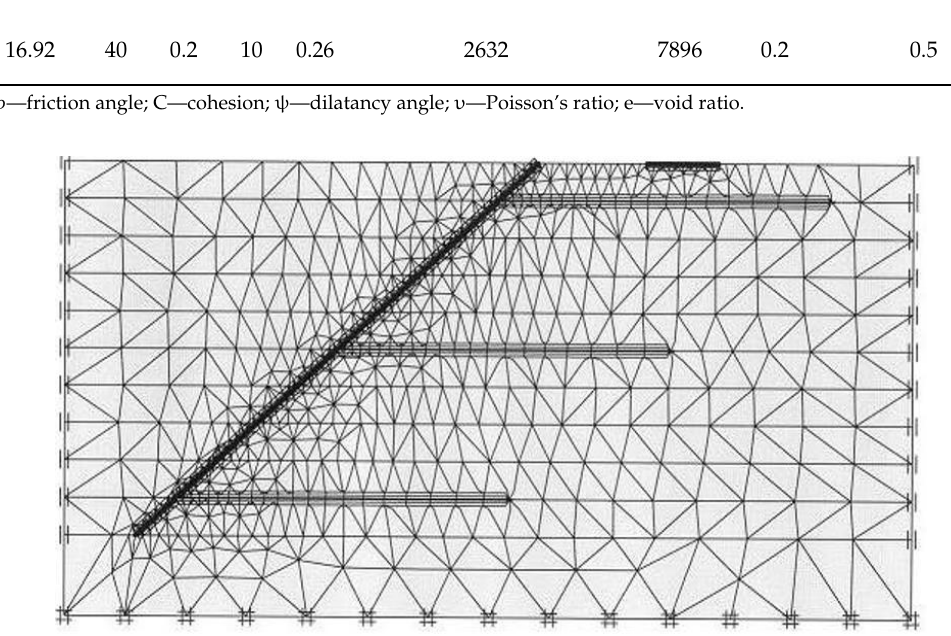
Figure 33. Triangular element discretization of nailed soil slope model.